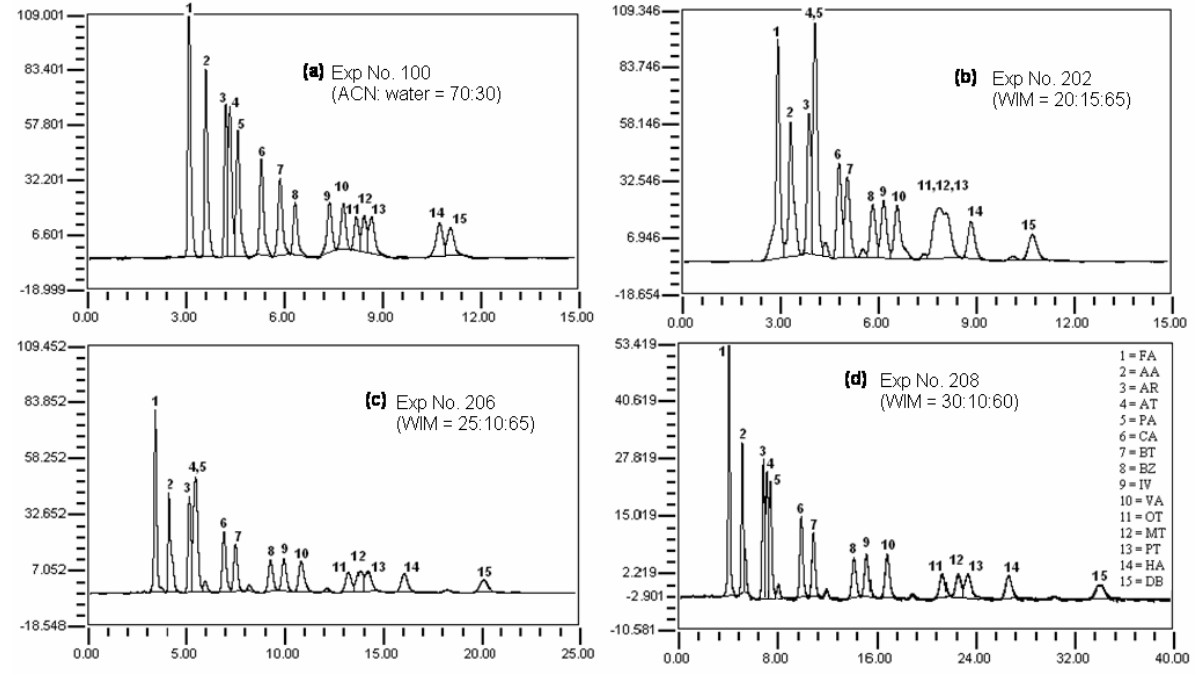
FIGURE 1. Chromatogram of reference experiment (No. 100; ACN:water = 70:30) and three WIM phase experiments with working standards (48 ng of